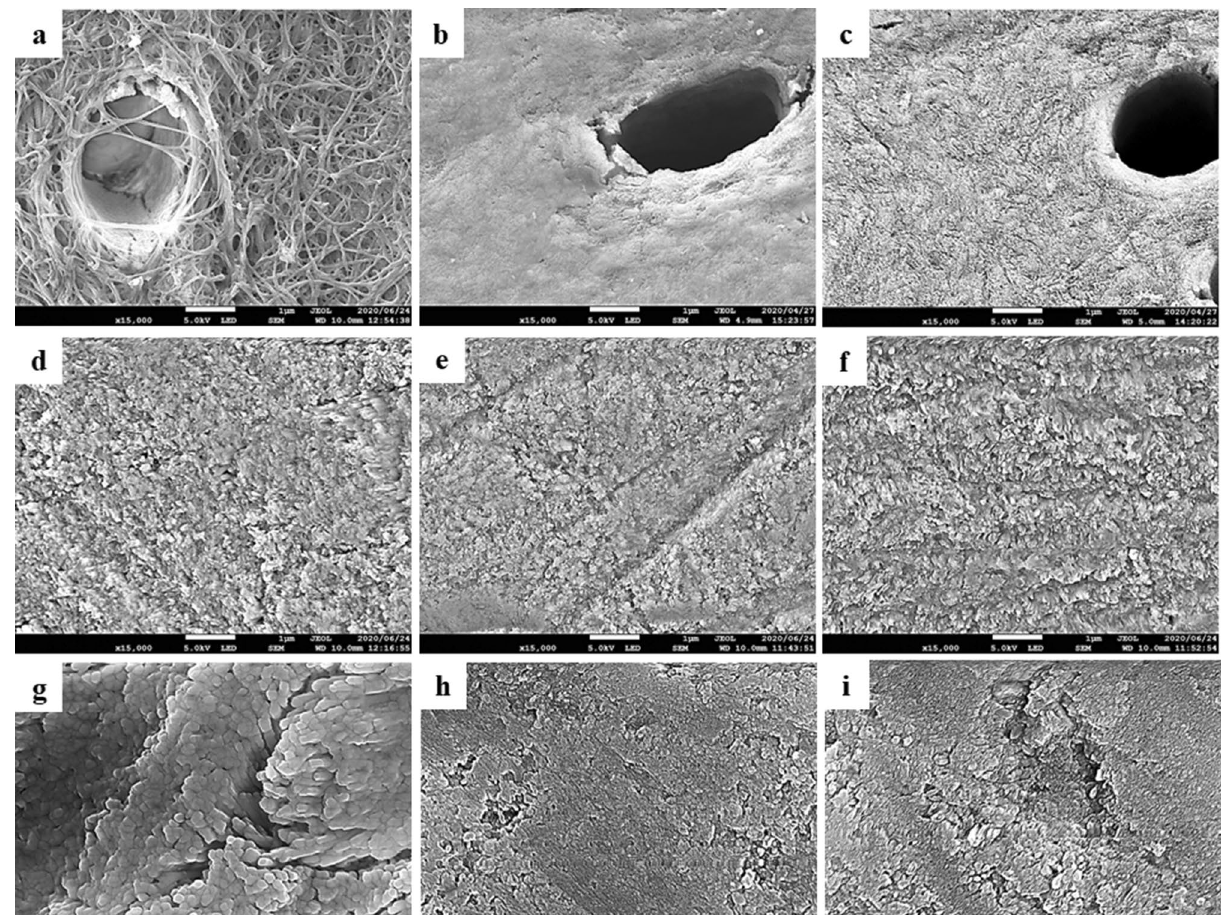
Figure 4. SEM images for the dentin and enamel surfaces at ×15,000 magnification (scale bar 1 µm), ( a ) control “dentin”, ( b ) S-PRG eluate “dentin”, ( c ) Borate “dentin”, ( d ) control “enamel”, ( e ) S-PRG eluate “enamel”, ( f ) Borate “enamel”, ( g ) control “enamel” at ×30,000 magnification while arrows refer to the interprismatic area (scale bar 0.1 µm), ( h ) S-PRG eluate “enamel” at ×30,000 magnification (scale bar 0.1 µm), ( i ) Borate “enamel” at ×30,000 magnification (scale bar 0.1